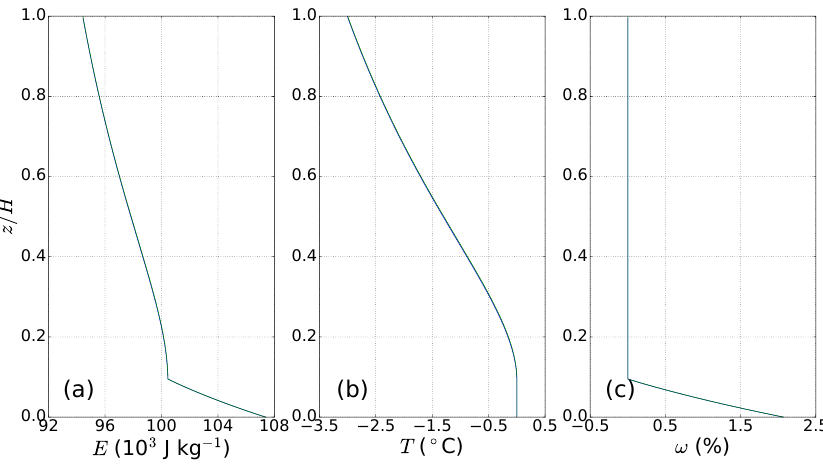
Figure 9. The vertical distribution of (a) enthalpy ( E ), (b) temperature ( T ), and (c) water content ( ω ) for enthalpy benchmark experiment B. The green lines indicate the analytical results (overlapped with model results).